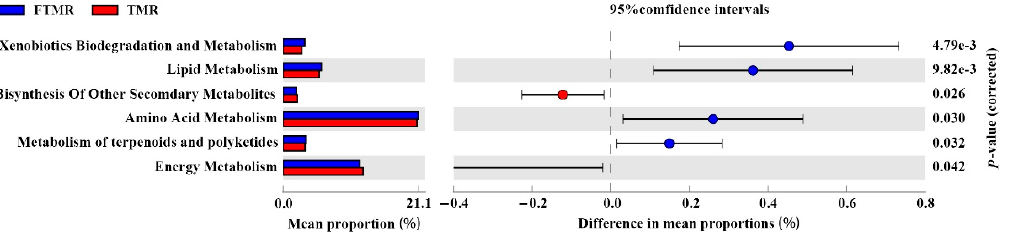
Figure 7. Phylogenetic Investigation of Communities by Reconstruction of Unobserved States (PICRUSt) analysis. Variance analysis of the Kyoto Encyclopedia of Genes and Genomes (KEGG) metabolic pathways in the second level. The graphs show the abundance ratio of different functions in two groups of samples. The middle shows the difference between the proportions of functional abundance in the 95% confidence interval, and the value at the rightmost is the p -value. p < 0.05 represents the significant difference. TMR, total mixed ration; FTMR, fermentation total mixed ration.